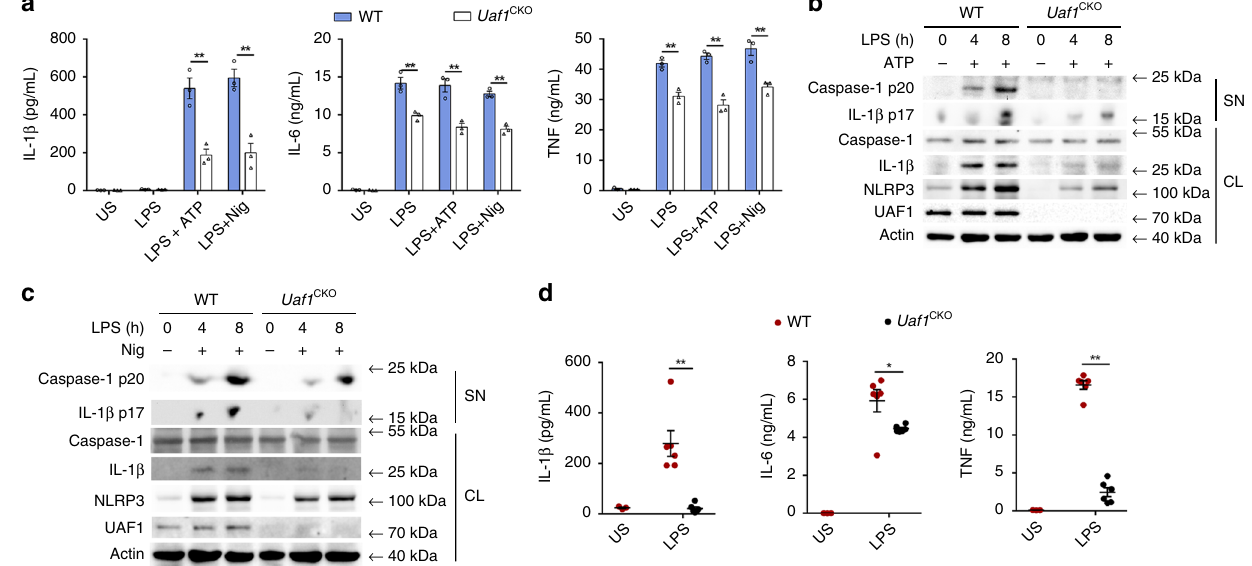
Fig. 1 UAF1 facilitates NLRP3 in fl ammasome activation. a ELISA analysis of IL-1 β , IL-6 and TNF secretion in mouse peritoneal macrophages from wild- type (WT) or Uaf1 CKO mice following priming with LPS for 8 h and subsequent stimulation with ATP or Nig for 40 min. US, unstimulated (mean ± SEM, two-tailed t -test Uaf1 CKO vs. WT, left panel: ** P = 0.0050, 0.0044 in sequence, middle panel: ** P = 0.0070, 0.0052, 0.0009 in sequence, right panel: ** P = 0.0035, 0.0014, 0.0079 in sequence; n = 3 independent experiments). b , c Western blot analysis of caspase-1 and IL-1 β cleavage in mouse peritoneal macrophages from WT or Uaf1 CKO mice after priming with LPS for the indicated time periods and then stimulated with ATP ( b ) or Nig ( c ) for 40 min. d ELISA analysis of serum levels of IL-1 β , IL-6 and TNF from WT or Uaf1 CKO mice after i.p. injection of LPS for 90 min (mean ± SEM, two-tailed t - test Uaf1 CKO vs. WT, left panel: ** P = 0.0005, middle panel: * P = 0.0321, right panel: ** P < 0.0001; n = 6 indepe n dent experiments). US, unstimulated; SN, supernatants; CL, cell lysates. Similar results were obtained from three independent experiments.